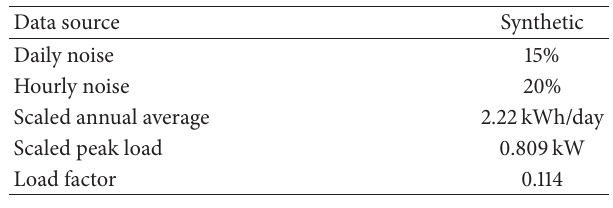
Table 1: Modelled PV system specification.